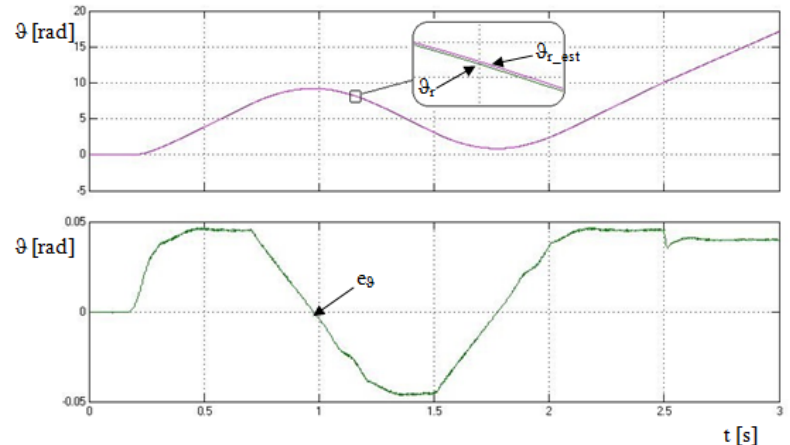
Figure 12. Rotor position estimation and estimation error with NSDR .